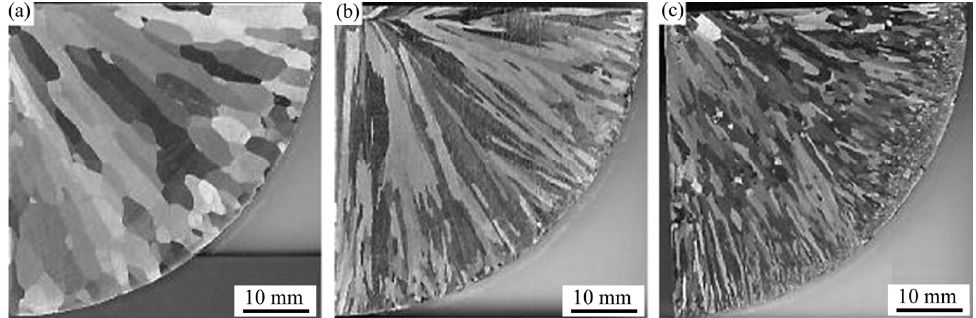
Figure 4. As-cast macrostructure of a 00Cr17 high-purity ferrite stainless steel with different cerium additions: ( a ) 0%, ( b ) 0.02%, and ( c ) 0.08%, reproduced from Reference [46], with permission of Cailiao Rechuli Xuebao/Transactions of Materials and Heat Treatment, 2011.